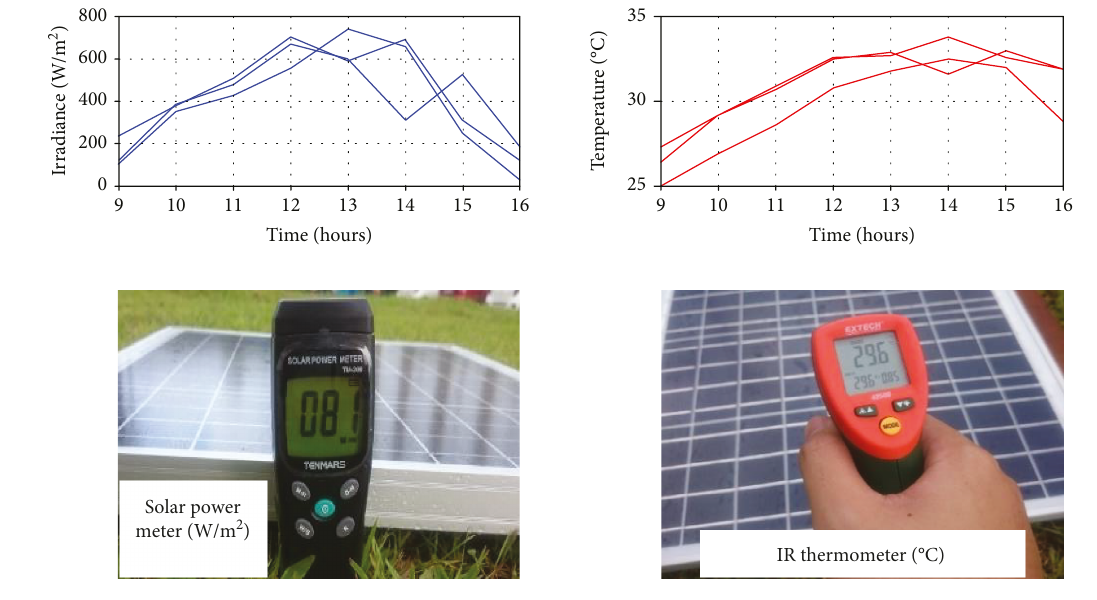
Figure 4: Measuring the solar irradiance and temperature on the solar PV panel.